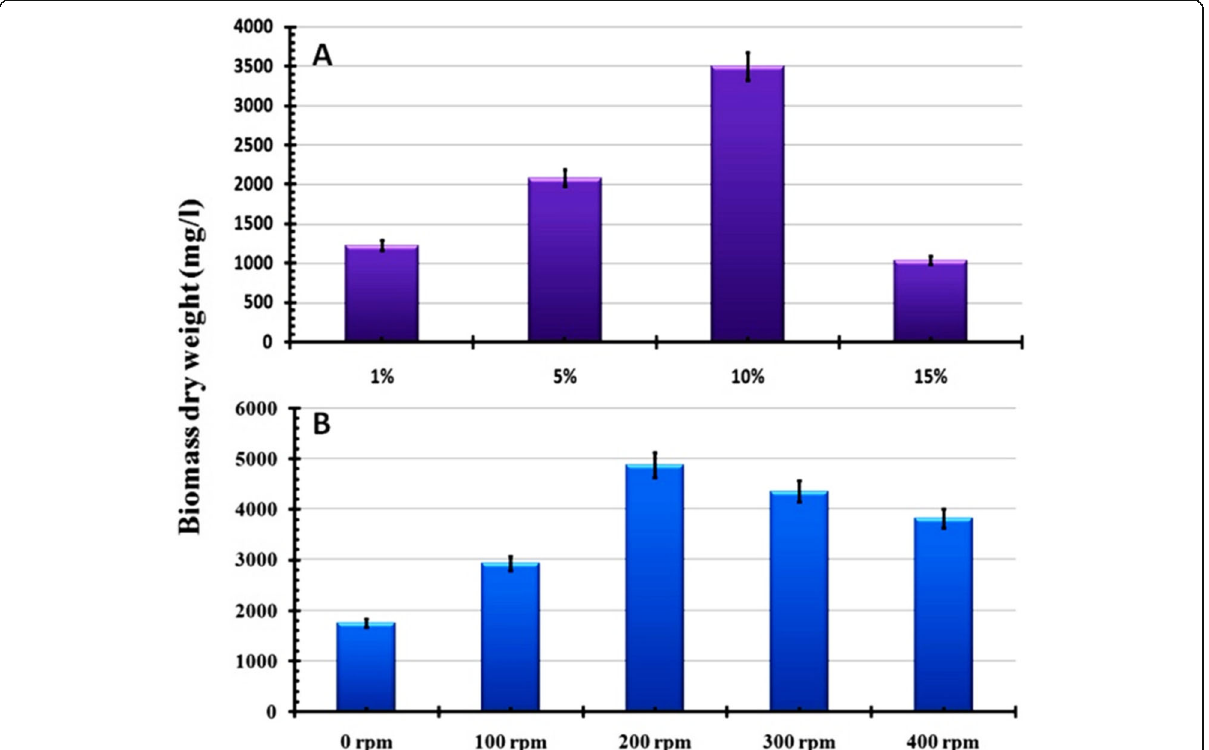
Fig. 4 Evaluation of the effect of culturing parameters on biomass dry weight of endophytic T. harzianum , a inoculums size, and b agitation speed